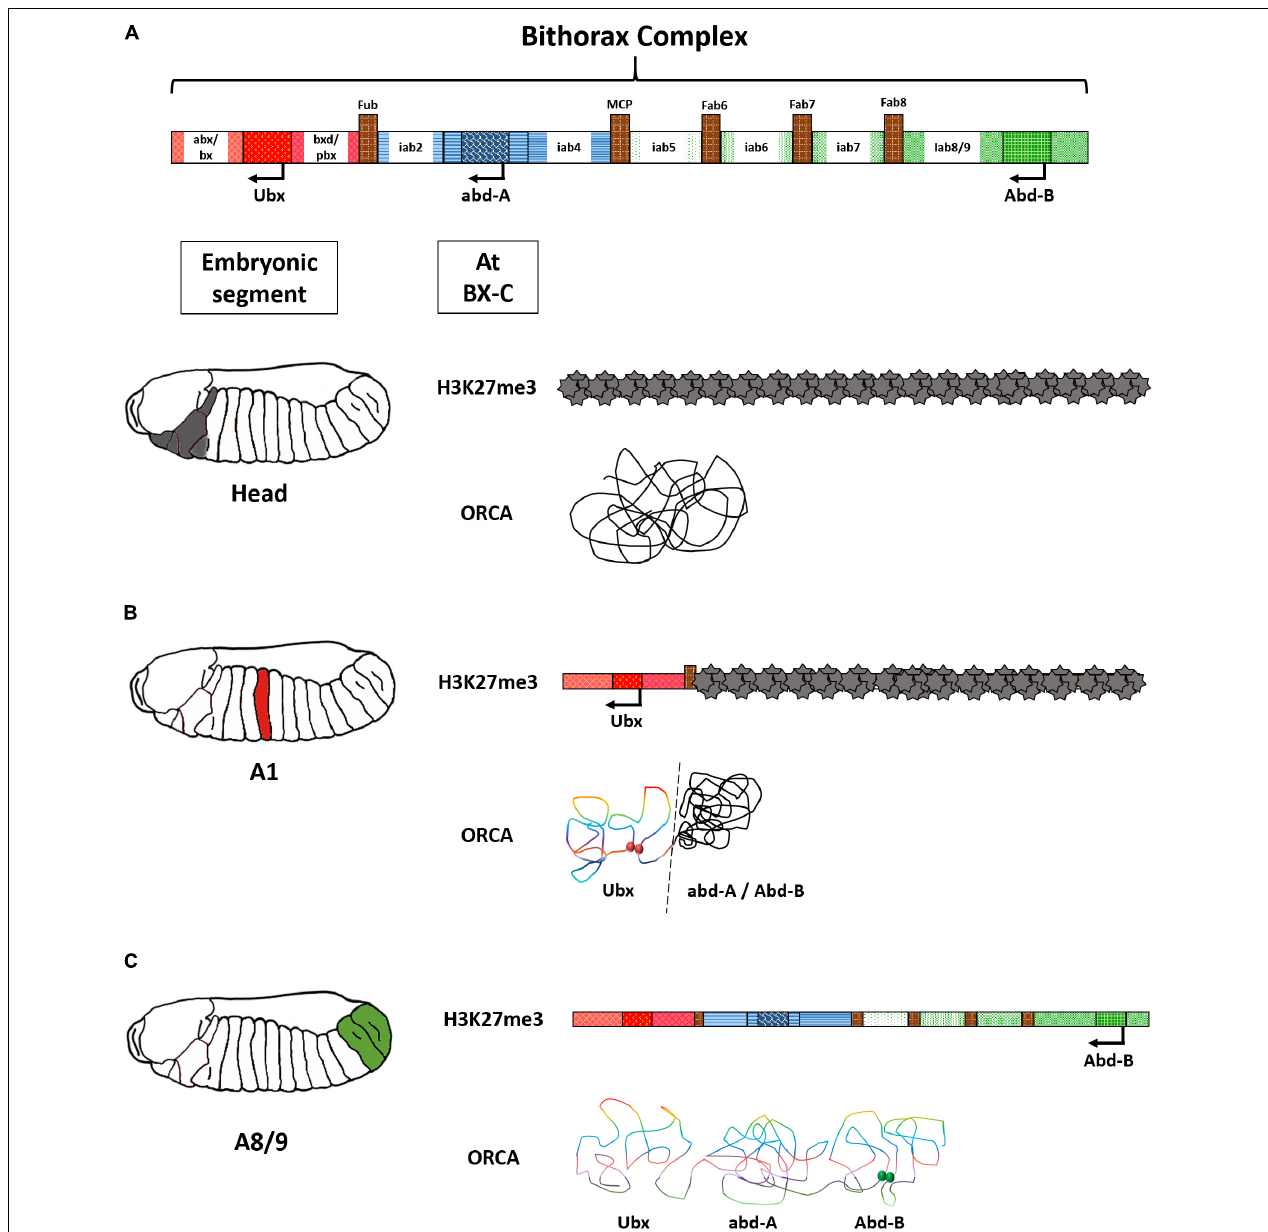
FIGURE 4 | Open for business model of the bithorax complex. (A) H3K27me3 marks on the bithorax complex in the head reveal complete repression of the locus. The same is corroborated by a representation of the ORCA image that shows clustering of the entire BX-C in one domain. (B) In A1, only the Ubx domain is derepressed and forms a distinct loop. Red spheres indicate contact points of Ubx enhancers with its promoter. (C) In A8/9, the entire BX-C is de-repressed and forms multiple loop domains. Green spheres indicate contact points of Abd-B enhancers with its regulators. The above image is a conceptual representation of data published by Bowman et al. (2014) and Mateo et al.